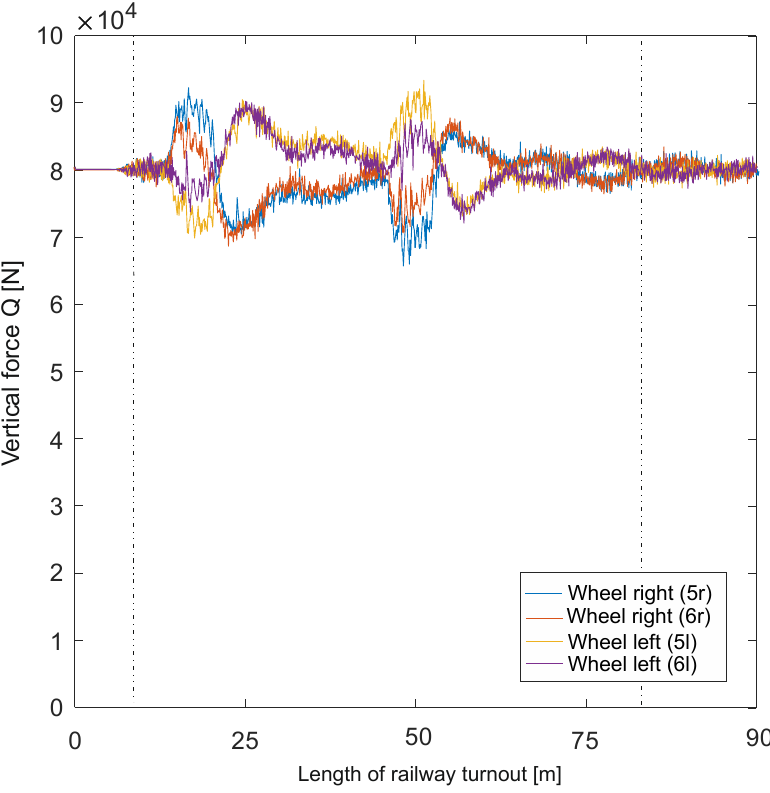
Figure 9. Vertical force on wheels at 250 km/h on a straight track through a turnout.